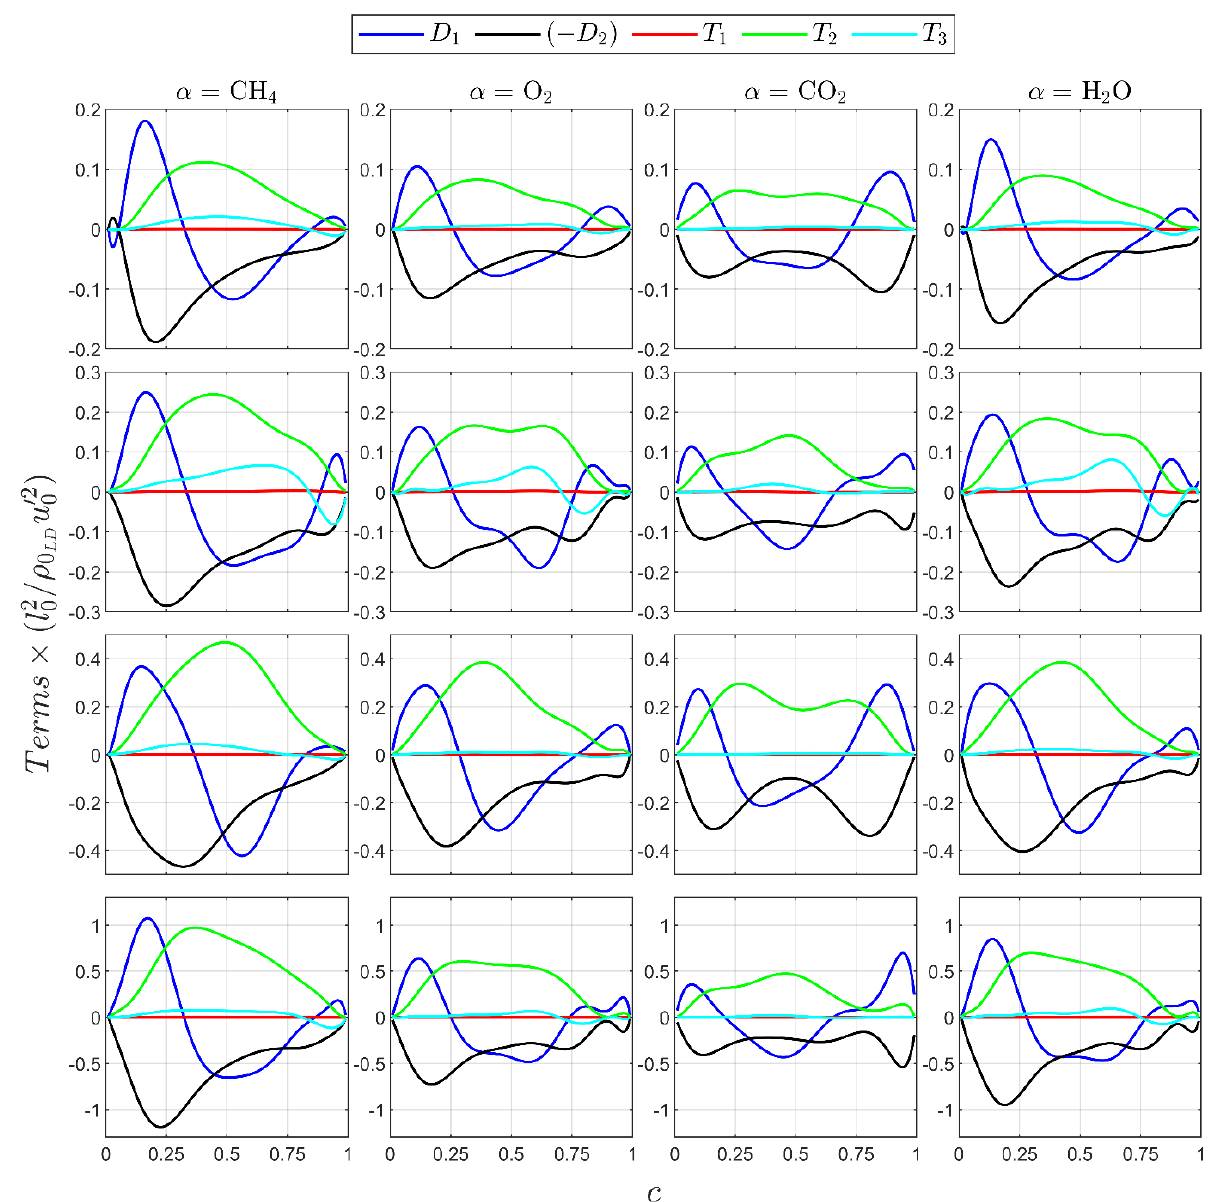
Figure 6. Profiles of the mean contributions of the terms on the right-hand side of the SDR transport equation (i.e., { D 1 , T 1 , T 2 , T 3 , − D 2 } × l 2 / ρ 0 𝑢 0′ 2 ) conditioned upon 𝑐 for different definitions of reaction progress variable c for homogeneous mixture MILD combustion cases with 3.5% (1 st and 3 rd row) and 4.8% O 2 concentration (2 nd and 4 th row) for initial u (cid:48) / S L = 4.0 (1 st and 2 nd row) and 8.0 (3 rd and 4 th row).